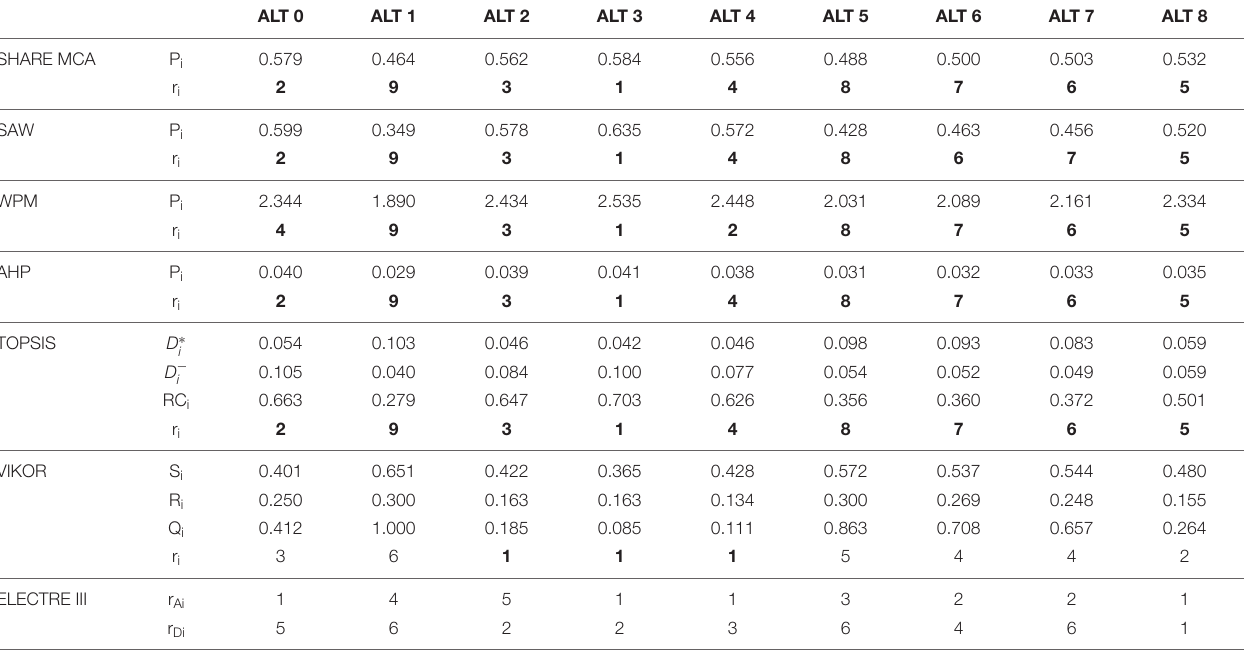
TABLE 4 | Results of the Graines torrent case study according to the different MCDM methods, using the first scheme of weights (P i = final performance value of alternative i; r i = position in the ranking; D ∗ i = distance from the ideal solution, D − i = distance from the negative-ideal solution, RC i = relative closeness, calculated in TOPSIS; S i , R i , Q i = values calculated in VIKOR; r Ai = position in the ascending ranking, r Di = position in the descending ranking, for ELECTRE